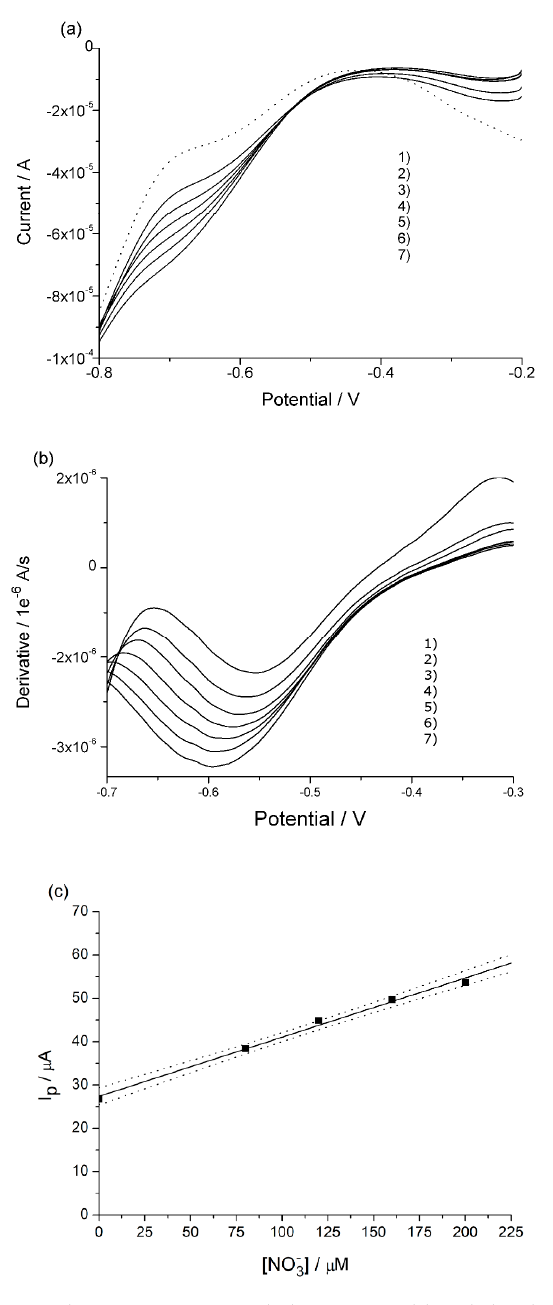
Figure 5. ( a ) Linear sweep voltammograms recorded in 5-times diluted chard extract acidified, at scan rate of 10 mV s − 1 ; ( b ) first derivative of LSV reported in ( a ); ( c ) calibration plot, with confidence bands at 90%, obtained by standard additions of nitrate in the following concentrations in μ M: 1) 0, 2) 80, 3) 120, 4) 160, 5) 200, 6) 240, 7). Table 2. Nitrate concentration values determined by electrochemical measurement (LSV) and ion chromatography (IC).